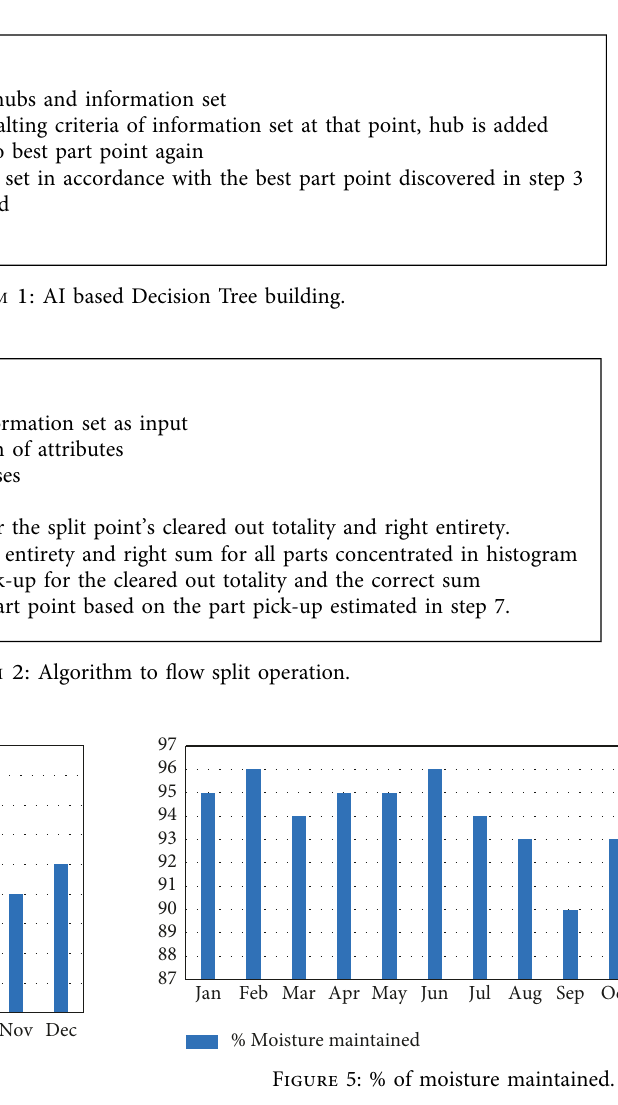
Figure 4: Crop prediction.